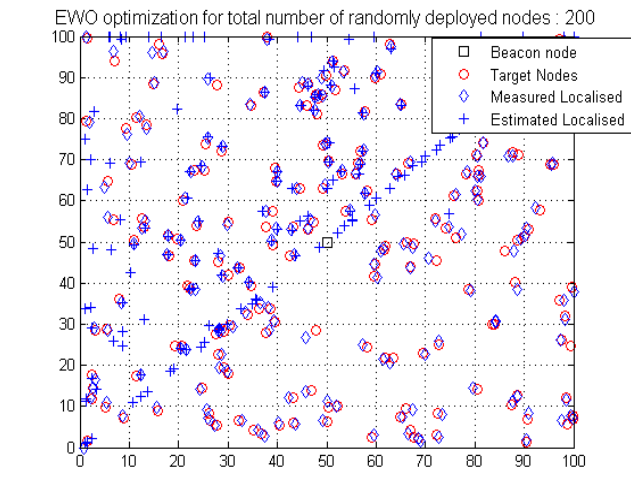
Figure 7. EW-PSO algorithm for randomly deployed mobile sensor nodes located in the target area